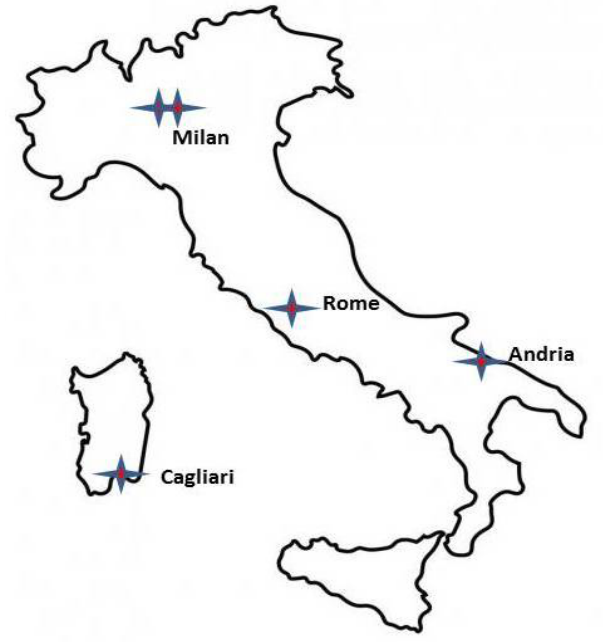
Figure 1. Map of Italy depicting the locations of the centers included in the study: two in the north of Italy (Milan), one in the center (Rome), one in the south (Andria), and one in Sardinia (Cagliari).